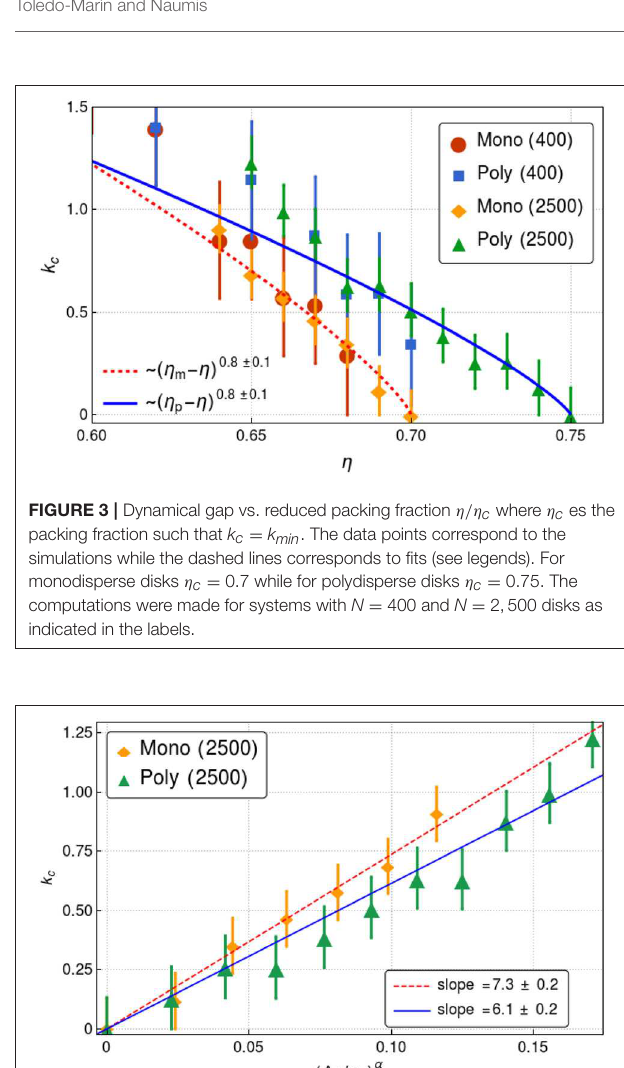
FIGURE 6 | Half-width of the transverse density current correlation function as a function of the wavenumber for packing fraction η and η 0.73 polydisperse for 2,500 hard disks. As k increase, the width = becomes larger which is qualitatively consistent with ( Trachenko and Brazhkin, 2015; Baggioli et al., 2019